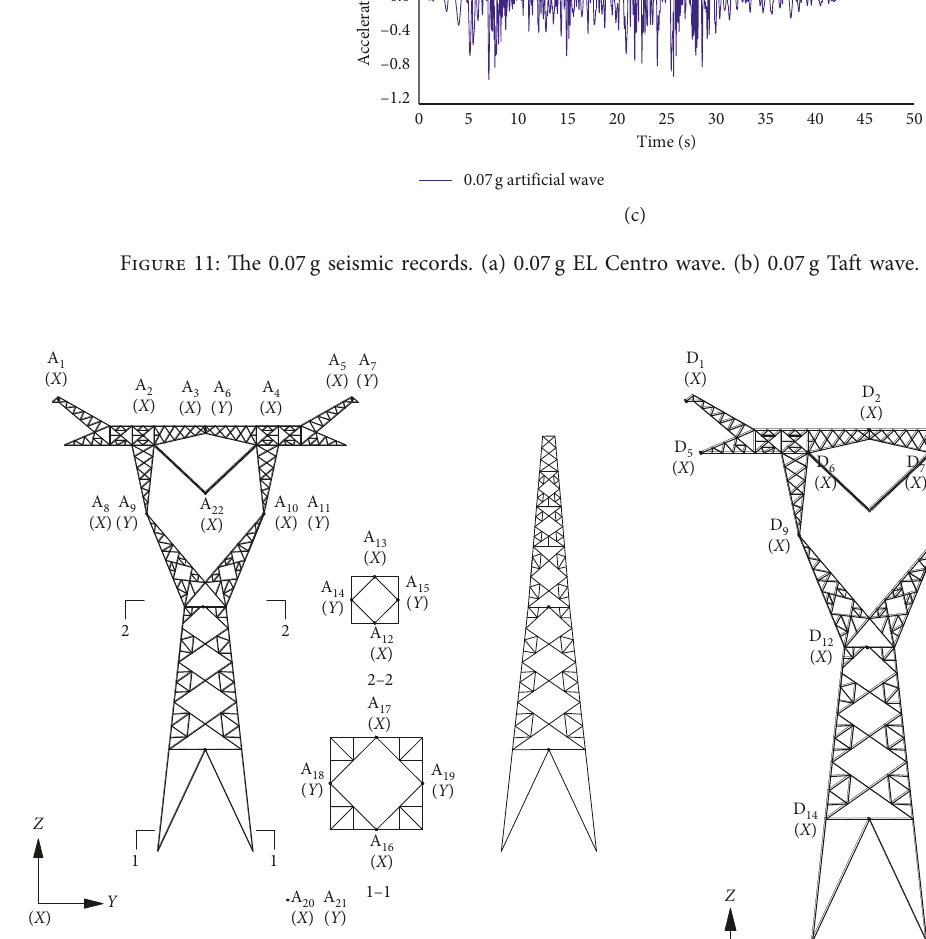
Figure 12: Layout of acceleration sensors.